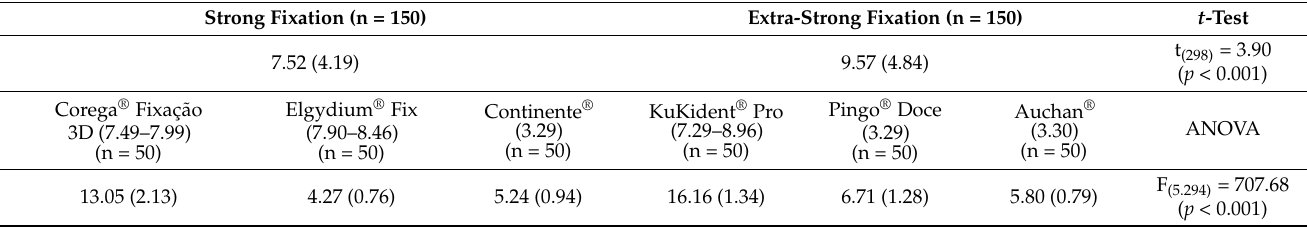
Table 3. Comparisons of adhesive retention by fixation and brand.